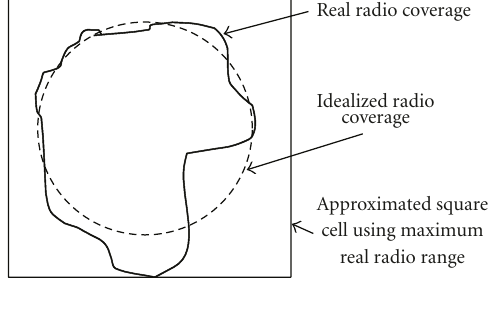
Figure 8: Worst-case localization cell.